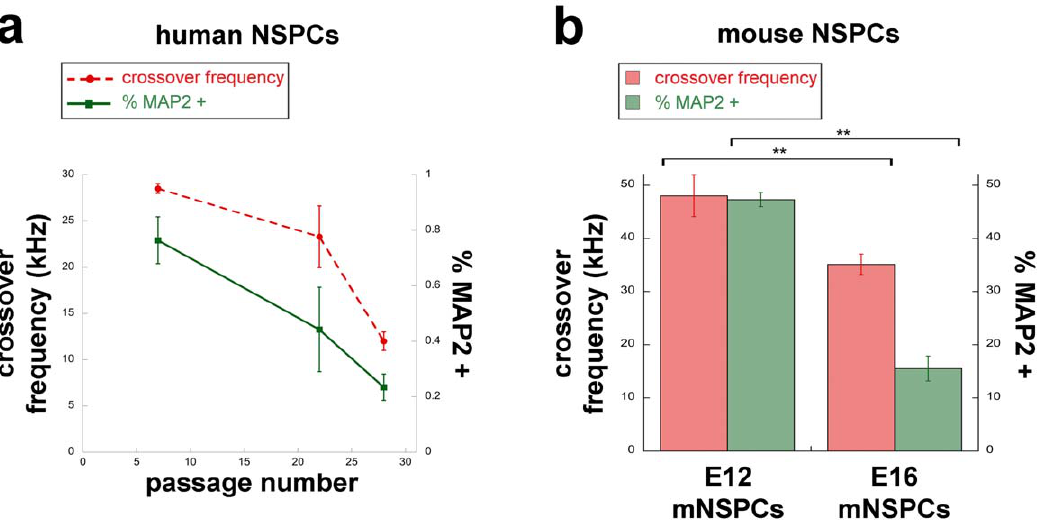
Figure 4. NSPC crossover frequency reflects neurogenic potential. (a) The crossover frequency of undifferentiated SC23 huNSPCs decreases with passage number (dashed red line) and directly correlates with neurogenic potential of the cells as shown by their ability to generate differentiated process-bearing cells expressing MAP2 (solid green line). Significance values are reported in the text. (b) The crossover frequency of undifferentiated mouse E12 and E16 NSPCs directly correlates with the ability of the cells to generate neurons (shown as the percentage of MAP2- positive cells with extended processes after differentiation). Error bars in all graphs represent s.e.m., **p , 0.01, n=3 or more separate experiments with different sets of